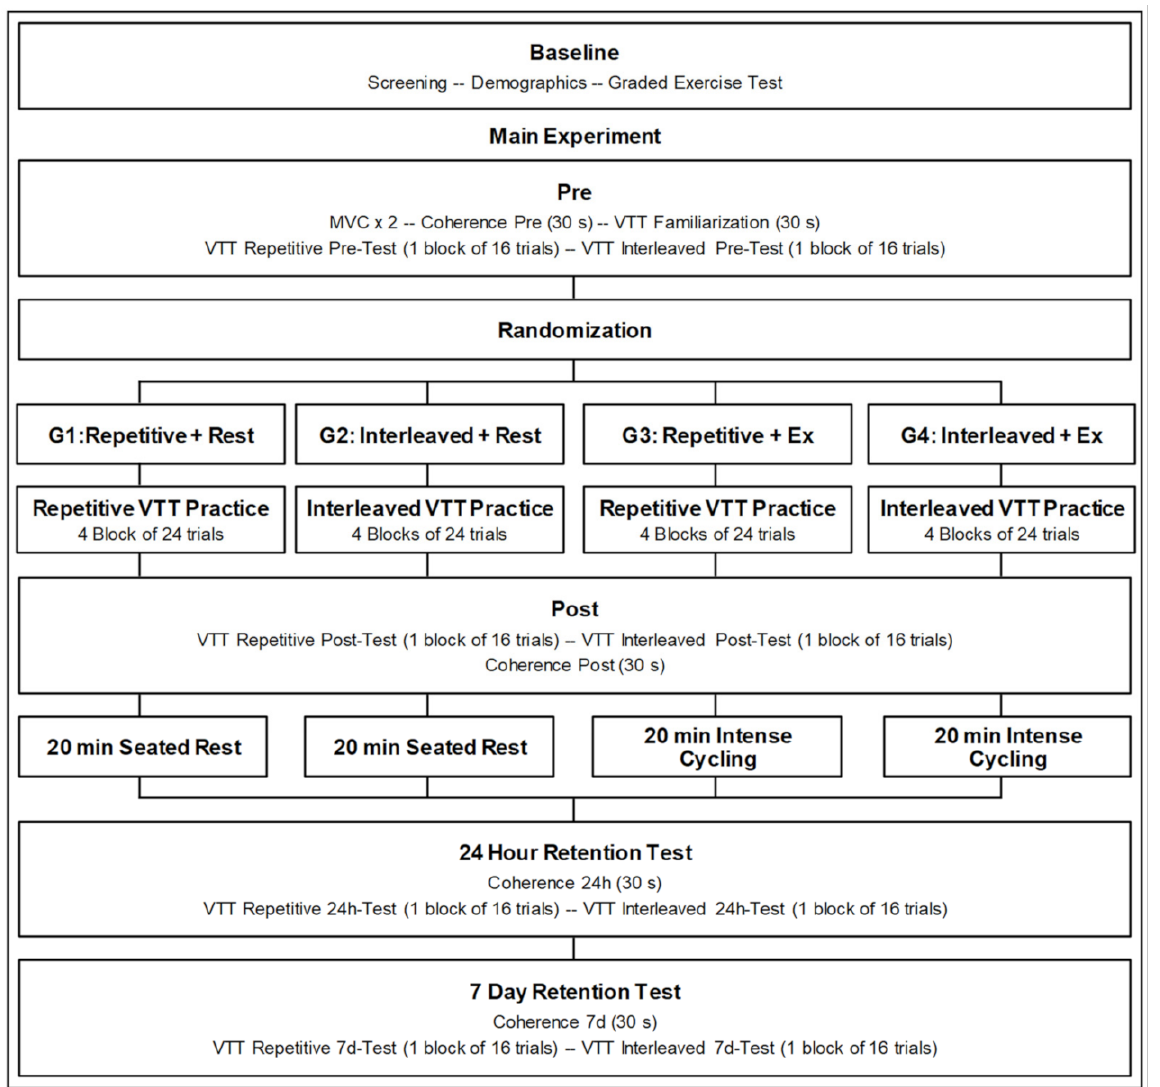
Figure 1. Overview of study design. MVC, maximum voluntary contraction; VTT, visuomotor tracking task; G1–G4, Groups 1–4; 24 h, 24 h; 7d,